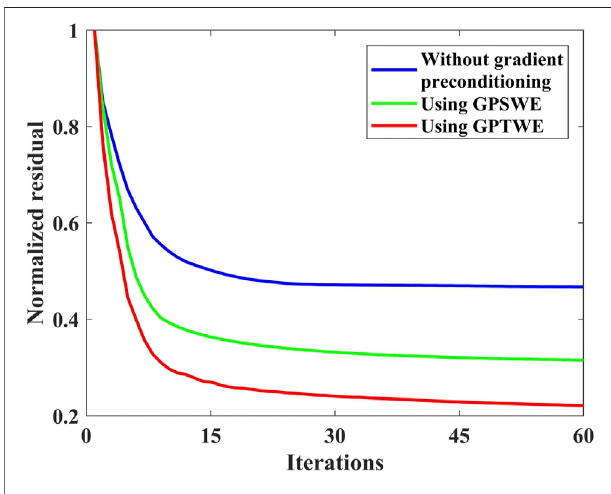
FIGURE 12 | Normalized residual